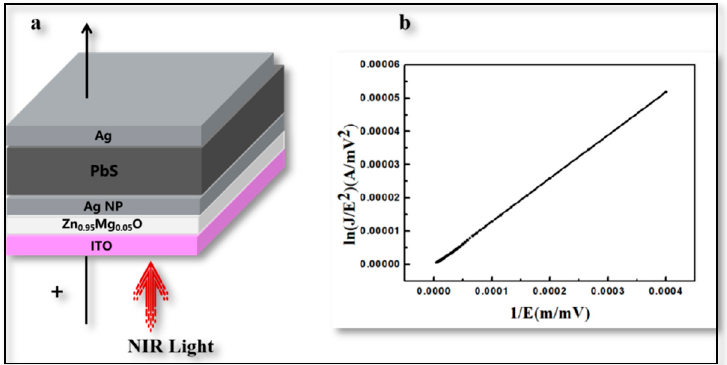
Figure 7. F-N Fitting Results. ( a ) Schematic cross-sectional view of tunneling structures. ( b ) Fitting results of ITO/Zn 0.95 Mg 0.05 O/Ag NP/PbS QDs/Ag structure.